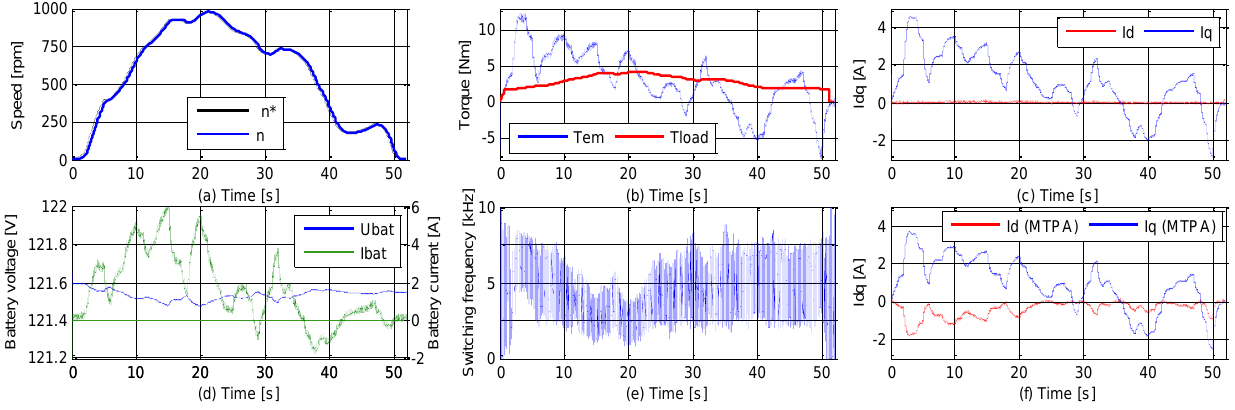
Figure 7. ARTEMIS driving cycle simulation. ( a , b , f ) With MTPA. ( a – e ) Without MTPA. Only the first 52 s are shown.